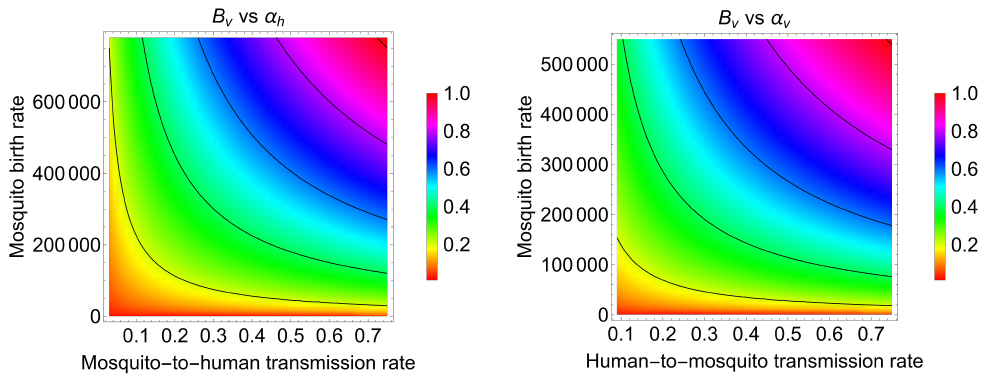
Figure 9. The contour plot of R A mosquito-to-human transmission rate ( α